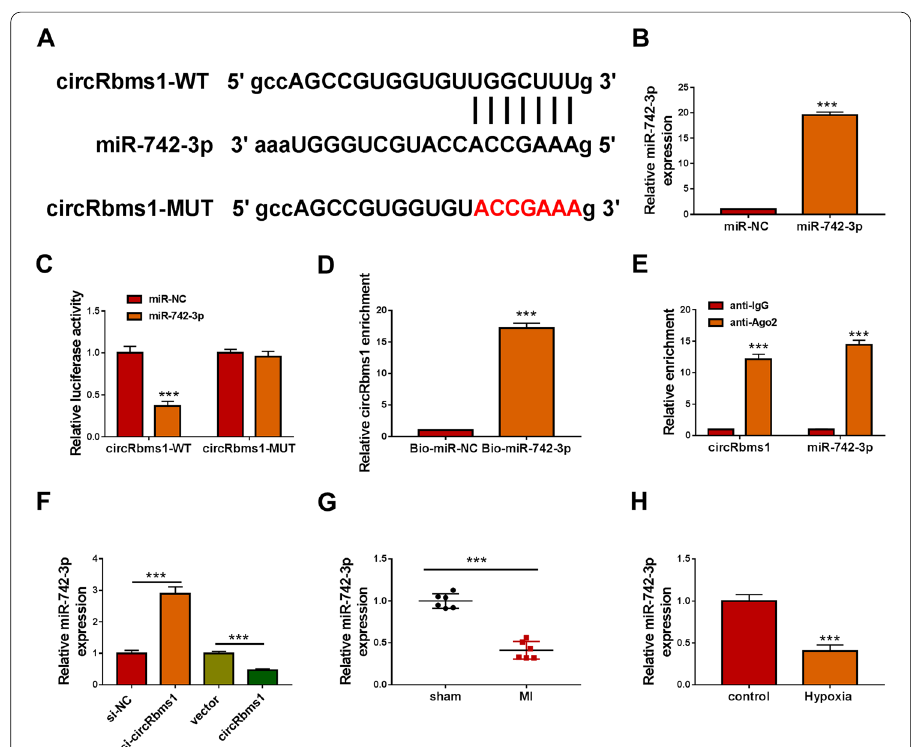
Fig. 3 CircRbms1 directly sponged miR-742-3p . A The fragments of circRbms1 -WT and circRbms1 -MUT. B The transfection efficiency of miR-742-3p mimic (50 nM) in H9c2 cells was confirmed by detecting miR-742-3p expression using qRT-PCR. Dual-luciferase reporter assay ( C ), RNA pull-down assay ( D ), and RIP assay ( E ) were used to verify the interactions between circRbms1 and miR-742-3p . F In H9c2 cells transfected with si-NC (50 nM), si- circRbms1 (50 nM), vector (4.0 µg), or circRbms1 (4.0 µg), the expression of miR-742-3p was examined by qRT-PCR. G MiR-742-3p expression in the heart tissues of sham mice ( n was assessed using qRT-PCR. H The expression of miR-742-3p in hypoxia-treated and untreated H9c2 cells was measured by qRT-PCR. All experiments were repeated three times. *** P <